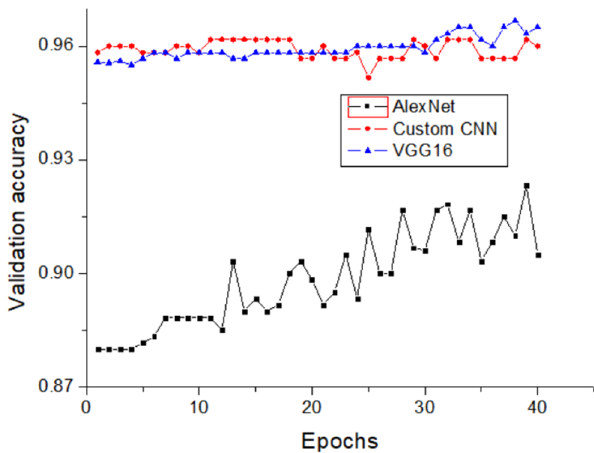
Figure 5. Validation accuracy in three convolutional networks.